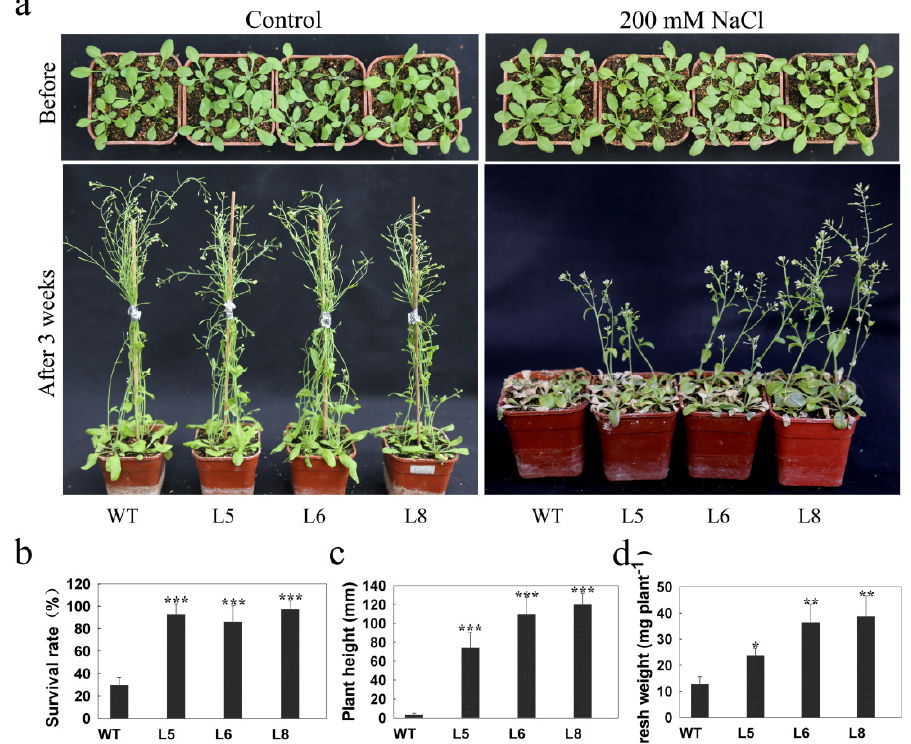
Figure 6. Enhanced tolerances to salt stress in LcSAIN3 -overexpressing Arabidopsis at the seedling stage. ( a ) Three-week-old seedlings in soil were treated with or without 200 mM NaCl for 3 weeks. The seedling survival rates ( b ) and plant height ( c ) and plant weight ( d ) were scored after the 3-week treatment. The mean and standard error were obtained from three biological replicates, ***, **, and * indicate significant differences at p < 0.001, p < 0.01, and p < 0.05, respectively..